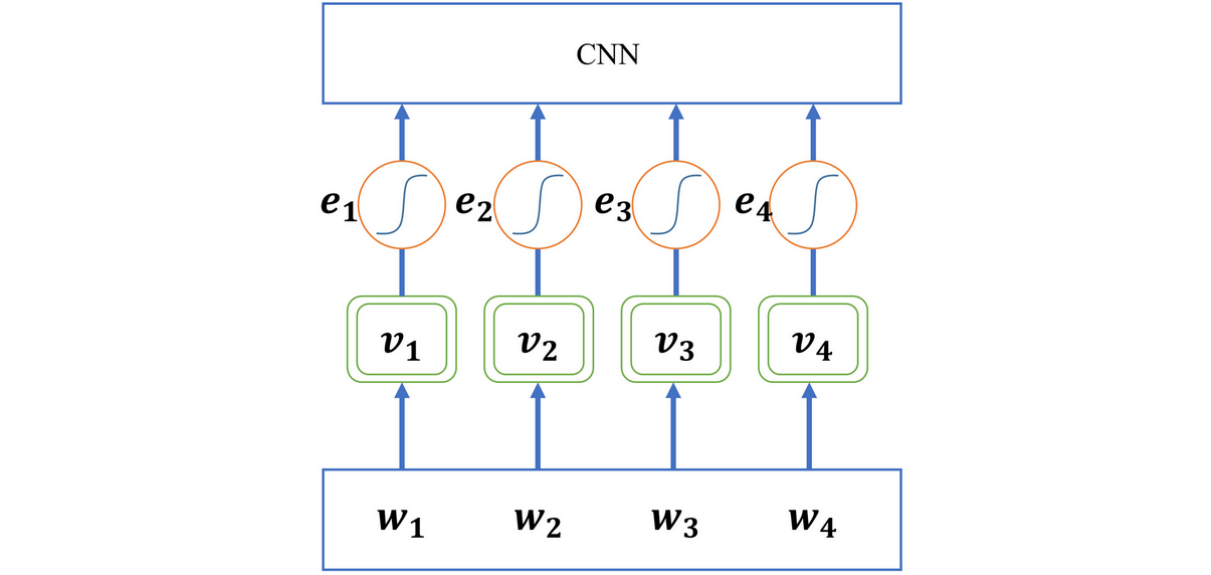
Figure 7. Computation graph of encoding a sentence xi with adversarial training. ei denotes the adversarial perturbation xi. Dropout is placed on the output of the variables in the double-lined rectangles. CNN: convolutional neural